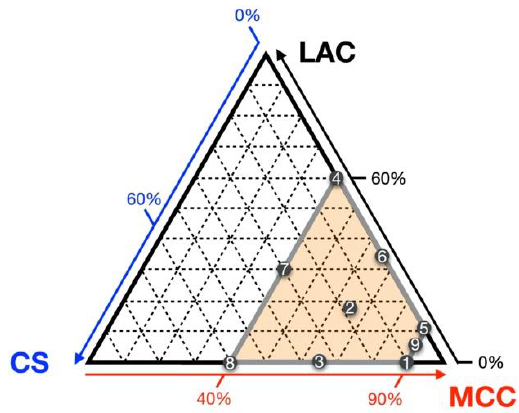
Figure 1. Excipient composition of model tablets. Each point represents the excipient composition and formulation number of one model tablet.